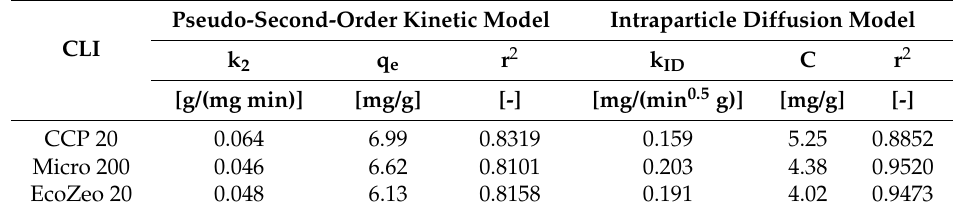
Table 8. Coefficients of adsorption kinetics according to the PSO and ID model of CCP 20, Micro